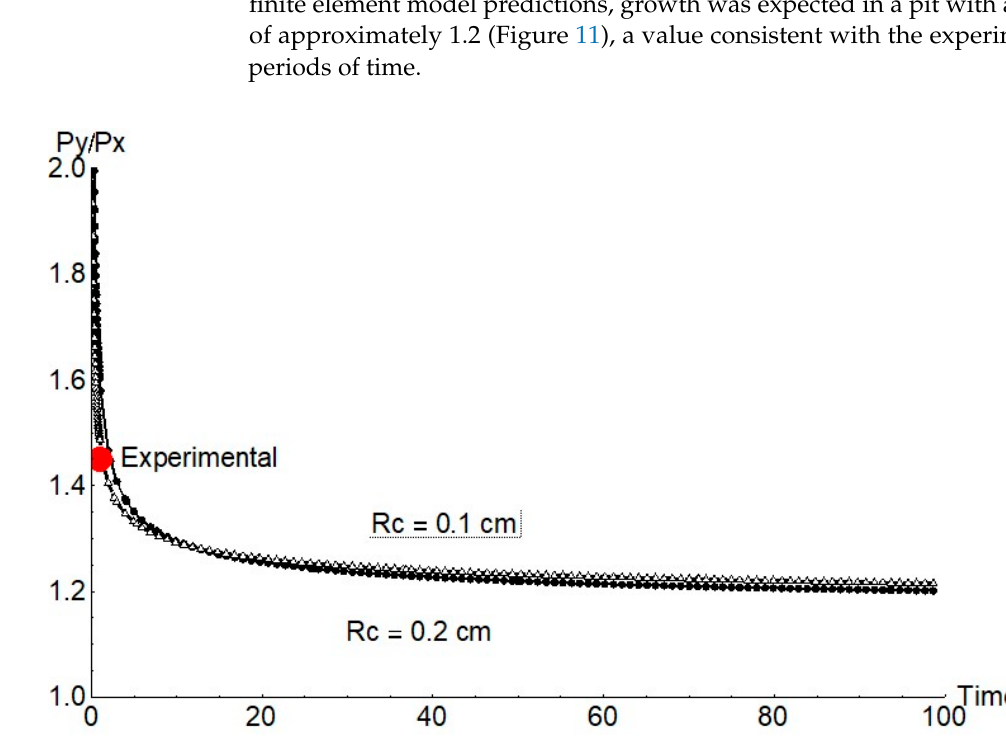
Figure 11. Py / Px ratio for 1 mm and 2 mm cathode radii (red circle = mean experimental value). Figure 11. P y /P x ratio for 1 mm and 2 mm cathode radii (red circle = mean experimental value).